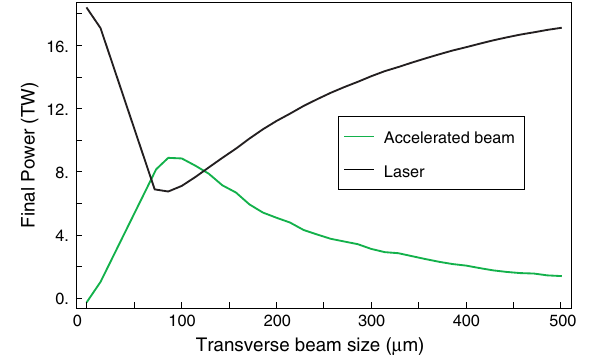
FIG. 14. Power absorbed by accelerated electrons and remain- ing laser power vs rms transverse beam size for the case of the uncompensated undulator and a 18 kA beam.